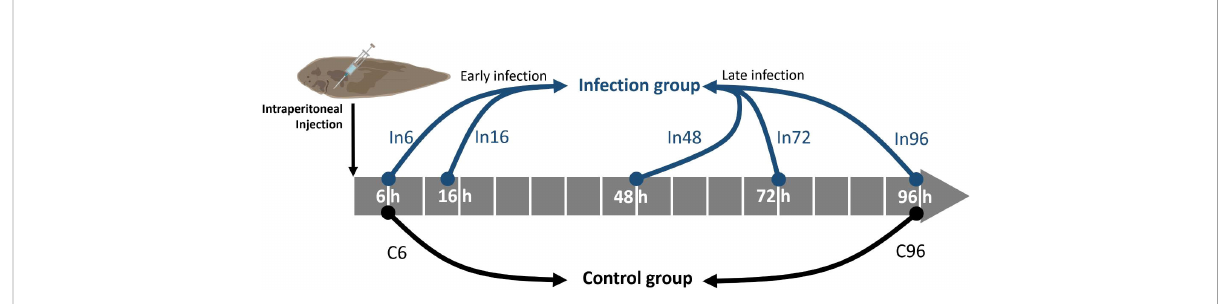
FIGURE 1 Schematic illustration of the sampling time points for bacterial challenge experiment. After the intraperitoneal injection of Vibrio harveyi , the blood and spleen were sampled at 6, 16, 48, 72, and 96 h, which were named as In6, In16, In48, In72, and In96, respectively. Correspondingly, the control groups were sampled at 6 and 96 h after the intraperitoneal injection of PBS in order to prevent the stresses caused by time, which were named as C6 and C96, respectively. The fi ve groups with bacterial infection were further divided into early-infection (In6 and In16) and late-infection (In48, In72, and In96)